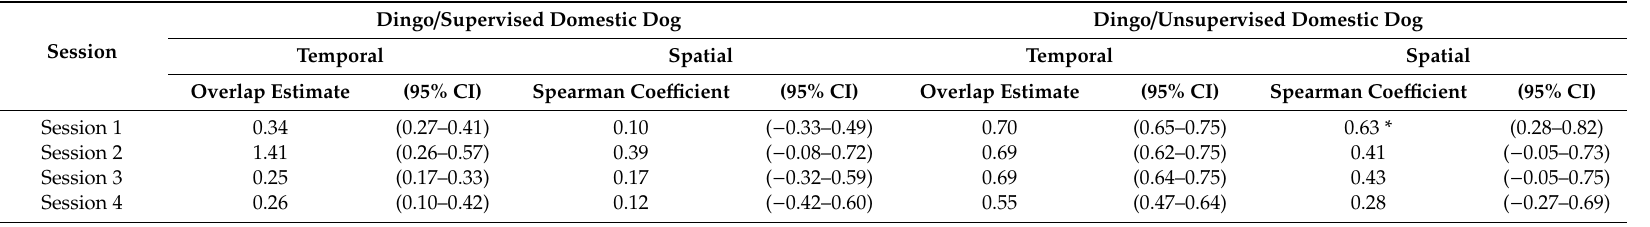
Table 2. Temporal overlap of daily activity patterns, and spatial correlation of dingoes and supervised and unsupervised domestic dogs in the NPA of